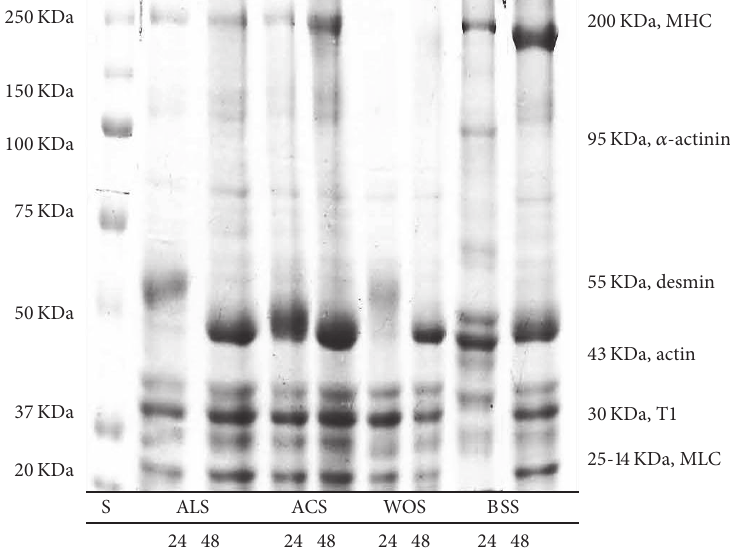
Figure 4: SDS-PAGE electrophoresis of marinating solutions. S: standard; ALS24: alkaline marinating solution after 24 h treatment; ALS48: alkaline marinating solution after 48h treatment; ACS24: acid marinating solution after 24 h treatment; ACS48: acid marinating solution after 48 h treatment; WOS24: water-oil emulsion after 24 h treatment; WOS48: water-oil emulsion after 48 h treatment; BSS24: brine solution after 24 h treatment; BSS48: brine solution after 48h